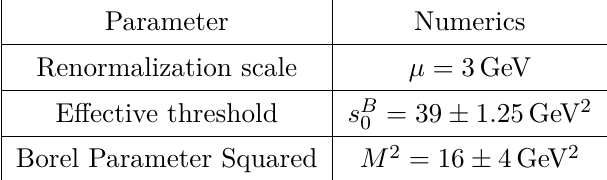
Table 2 . Values and intervals of the internal